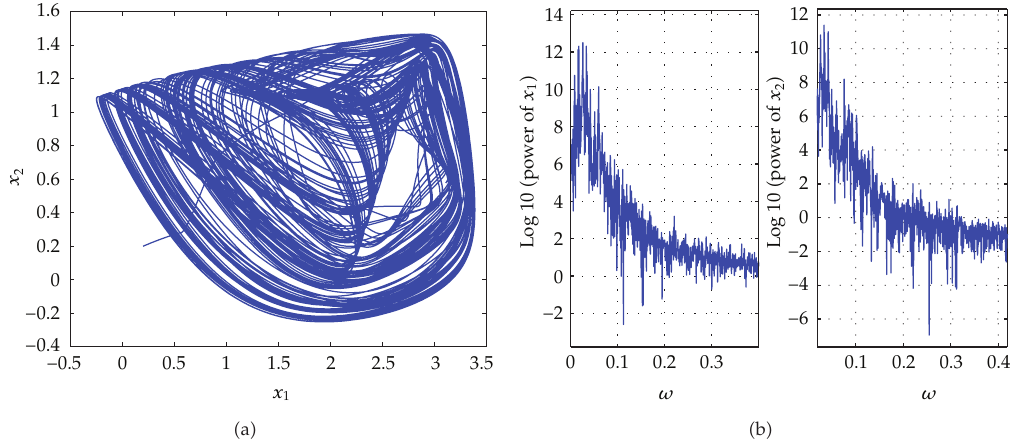
Figure 3: (cid:6) a (cid:7) Phase plot of system (cid:6) 4.4 (cid:7) with initial condition (cid:6) 0 . 2 , 0 . 2 (cid:7) . (cid:6) b (cid:7) Power spectrums of time series of x 1 and x 2 for system (cid:6) 4.4 (cid:7)